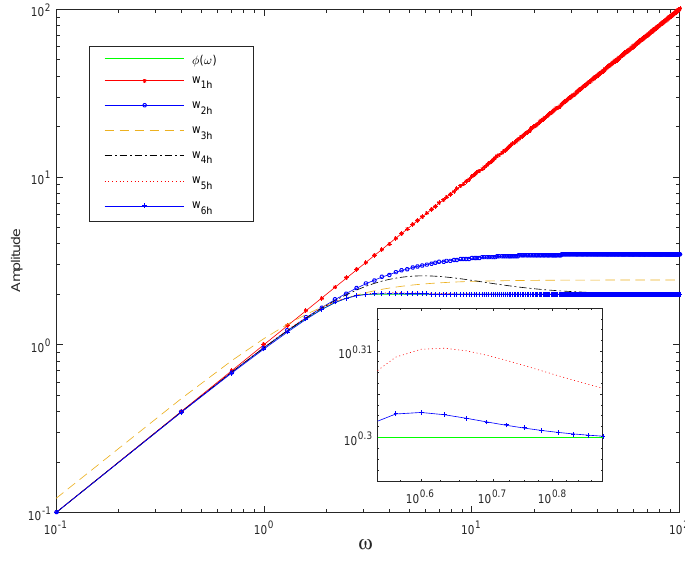
Figure 4. Rational approximation for φ ( ω )